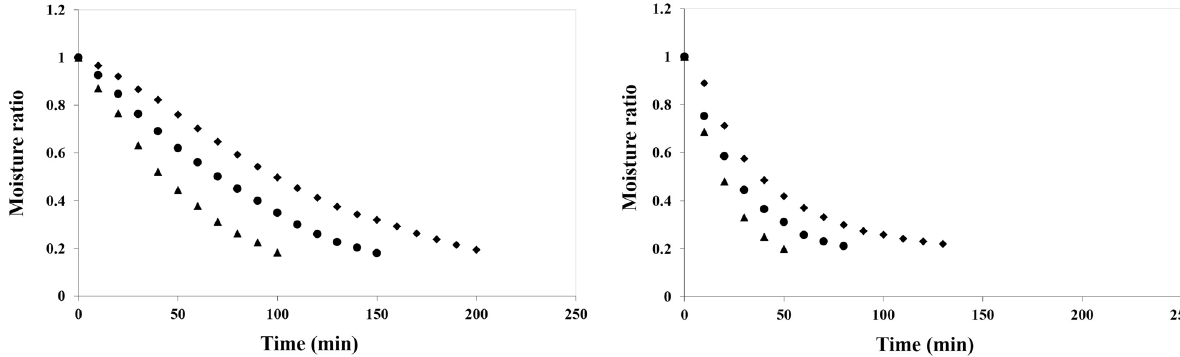
Figure 2. Moisture ratio versus drying time for apple slice under different drying: ( a ) air temperature (( ♦ ) 50 °C, ( ) 60 °C, ( ▲ ) 70 °C); ( b ) microwave powers (( ♦ ) 90 W, ( ●